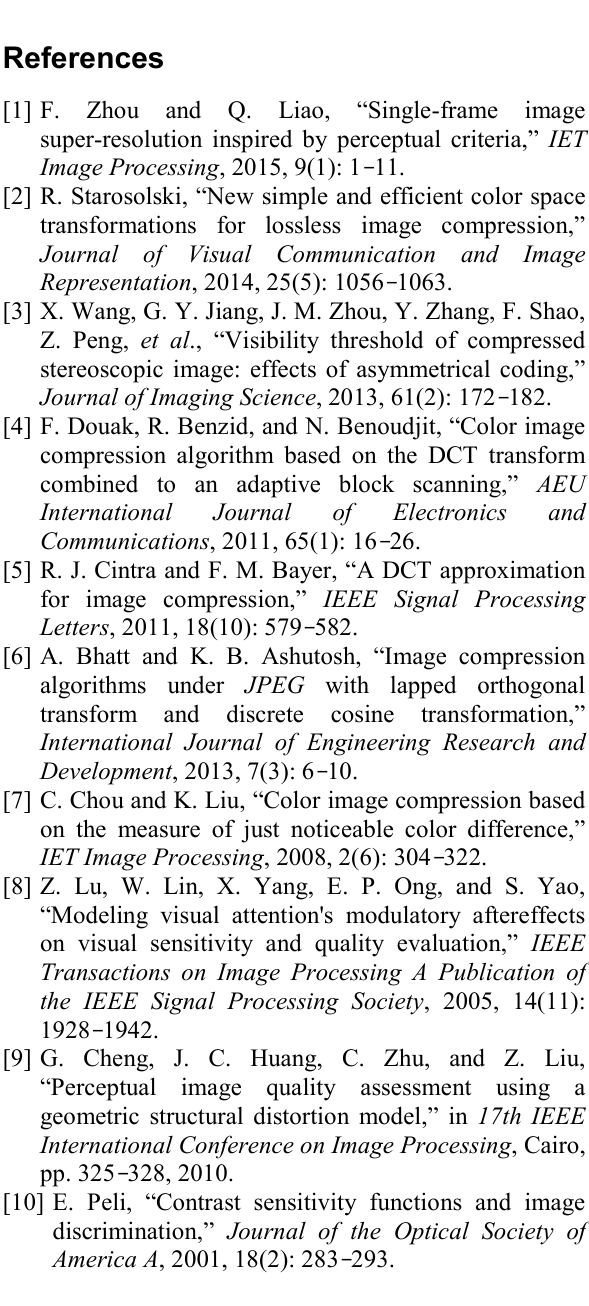
table generation on JPEG image compression,”